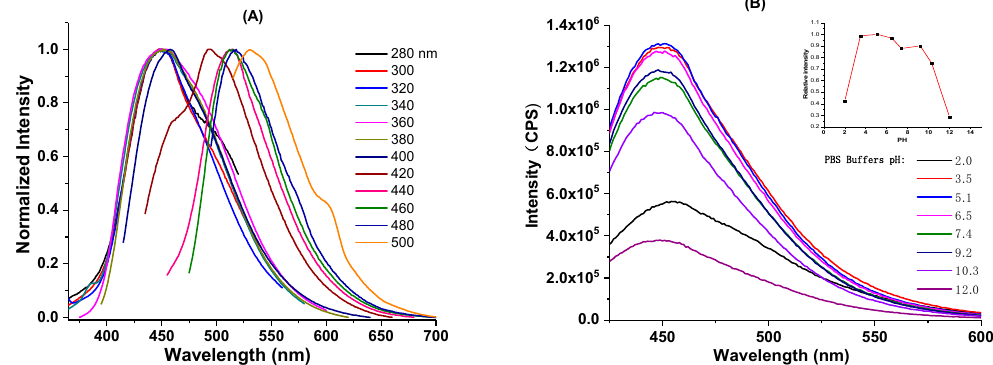
Figure 3. ( A ) Normalized emission spectra of C-dots; ( B ) fluorescence emission spectra of C-dots excited at 360 nm under di ff erent pH conditions (the inset shows the relative fluorescence intensity of C-dots excited at 360 nm under different pH).